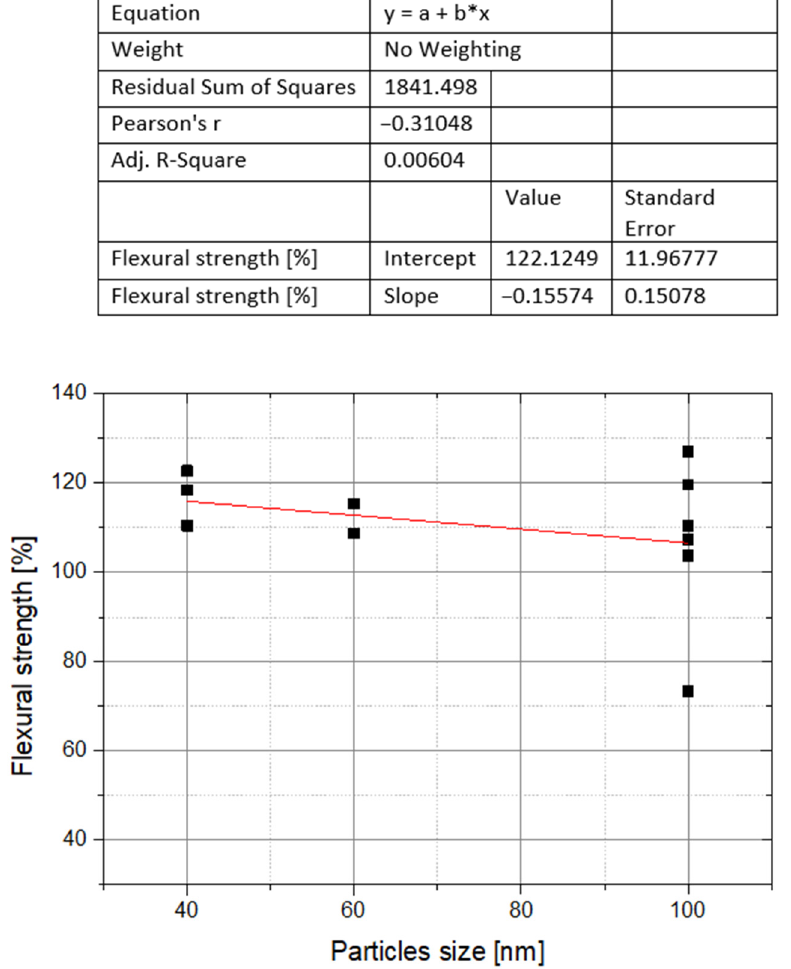
Figure 4. The effect of nano-ZrO 2 particle size on the flexural strength of PMMA composites for the concentration range of nano-ZrO 2 from 0.5 to 5 wt%. The results of individual studies.